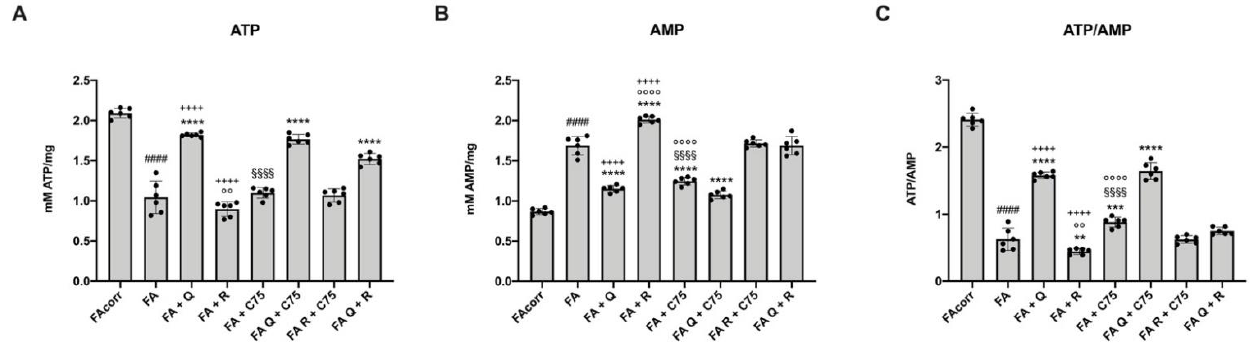
Figure 6. Modulation of ATP and AMP intracellular concentrations and consequent energy status in FA cells treated with quercetin, rapamycin, and C75, alone or in combination . All data represent experiments conducted after 48 h of drug treatments. ( A ) Intracellular ATP content. ( B ) Intracellular AMP content. ( C ) ATP/AMP ratio, as a marker of cellular energy status. (Q = quercetin alone; R = rapamycin alone; C75 = C75 alone; Q + C75 = quercetin/C75 combination; R + C75 = rapamycin/C75 combination; Q + R = quercetin/rapamycin combination). Each graph represents four independent experiments and data are expressed as mean ± S.D. For FA and FA-corr cells, data are representative of four different Fanc-A lymphoblast cell lines. Statistical analysis was performed via one-way ANOVA followed by Tukey multiple comparison test. #### indicates a p < 0.0001 between FA cells and FA-corr cell lines. **, ***, or **** indicate a p < 0.01, 0.001, or 0.0001 between untreated and treated FA cells. ++++ indicates a p < 0.0001 between treatment with quercetin or rapamycin alone and quercetin/rapamycin combination; §§§§ indicates p < 0.0001 between treatment with quercetin or C75 alone and quercetin/C75 combination; °°, or °°°° indicate a p < 0.01, or 0.0001, respectively, between treatment with rapamycin or C75 alone and rapamycin/C75 combination.